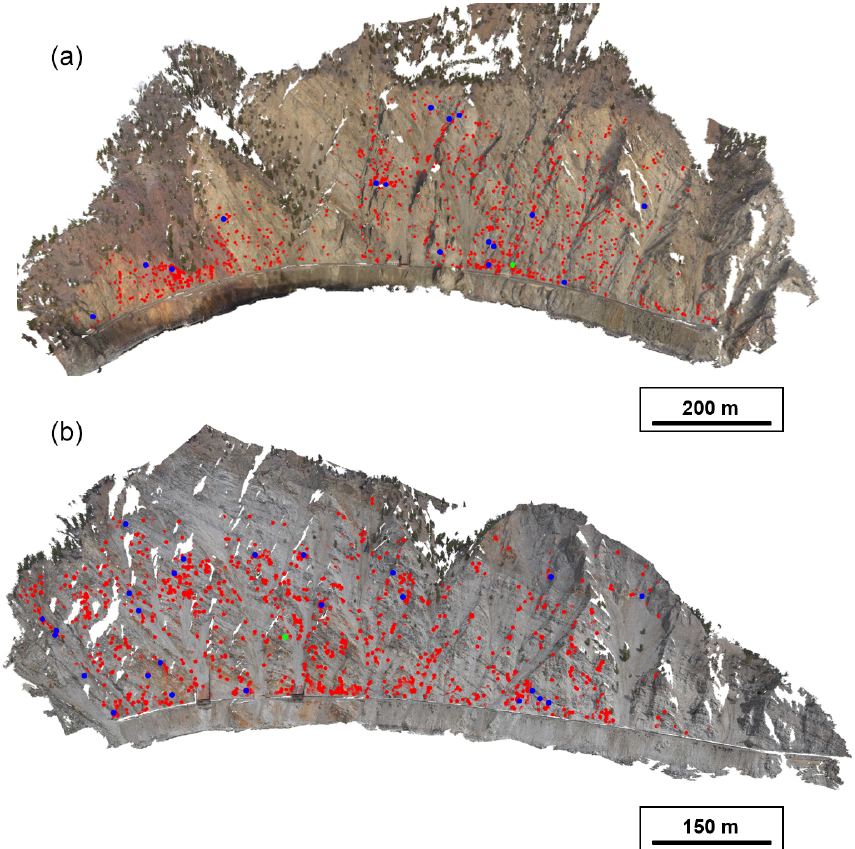
Figure 12. The White Canyon rockfall database. The centroid of each rockfall event is displayed as a red dot on the photogrammetry model. The blue dots correspond to the 50 rockfall events analyzed in detail. The light green dots correspond to the events analyzed in Fig. 14. (a) White Canyon West results. (b) White Canyon East